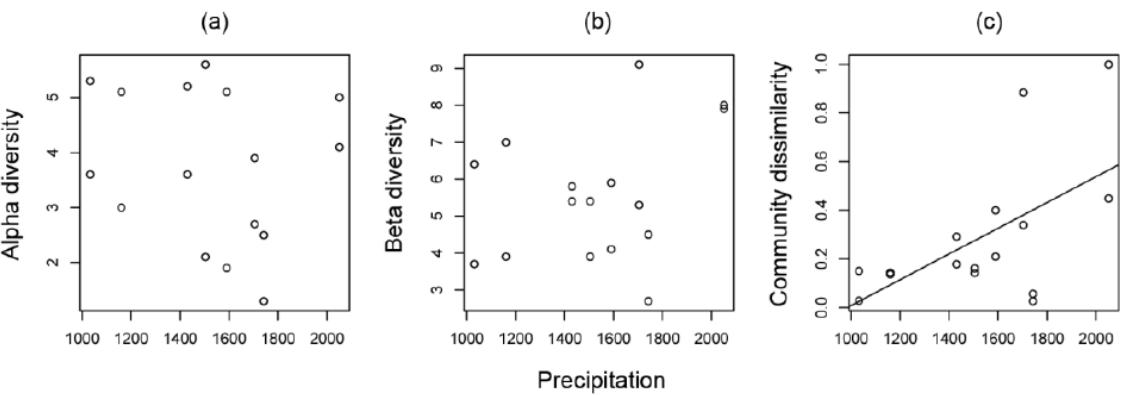
Figure 2. Linear model between precipitation and ( a ) the mean number species per tree (alpha diversity, r 2 = −0.036, F = 0.481, P = 0.450), ( b ) beta diversity (r 2 = 0.047, 1,14 F = 1.733, P = 0.209) and ( c ) community dissimilarity (r 2 = 0.280, F 1,14 P = 0.021) based on species found on all 10 trees per plot.